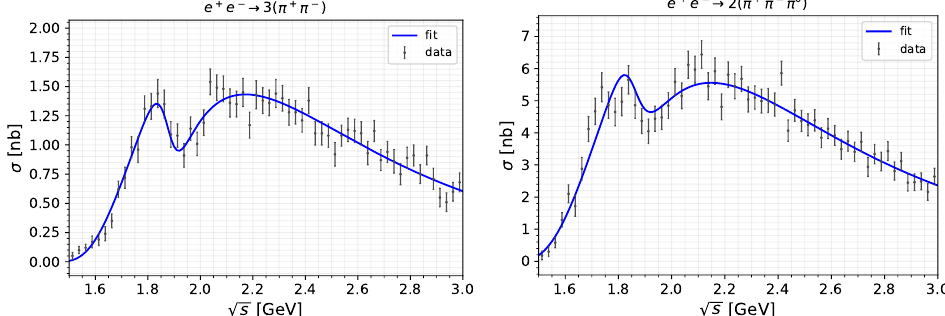
Figure 22 . Cross-section for the charged 3( π + π − ) (left panel) and neutral 2( π + π − π 0 ) (right panel) hadronic final states. The blue curve shows the best fit solution to the cross-section, obtained considering the parameterization described in eq. (B.4) and (B.5) and the fit values of table 7. The black points and error bars represent data from